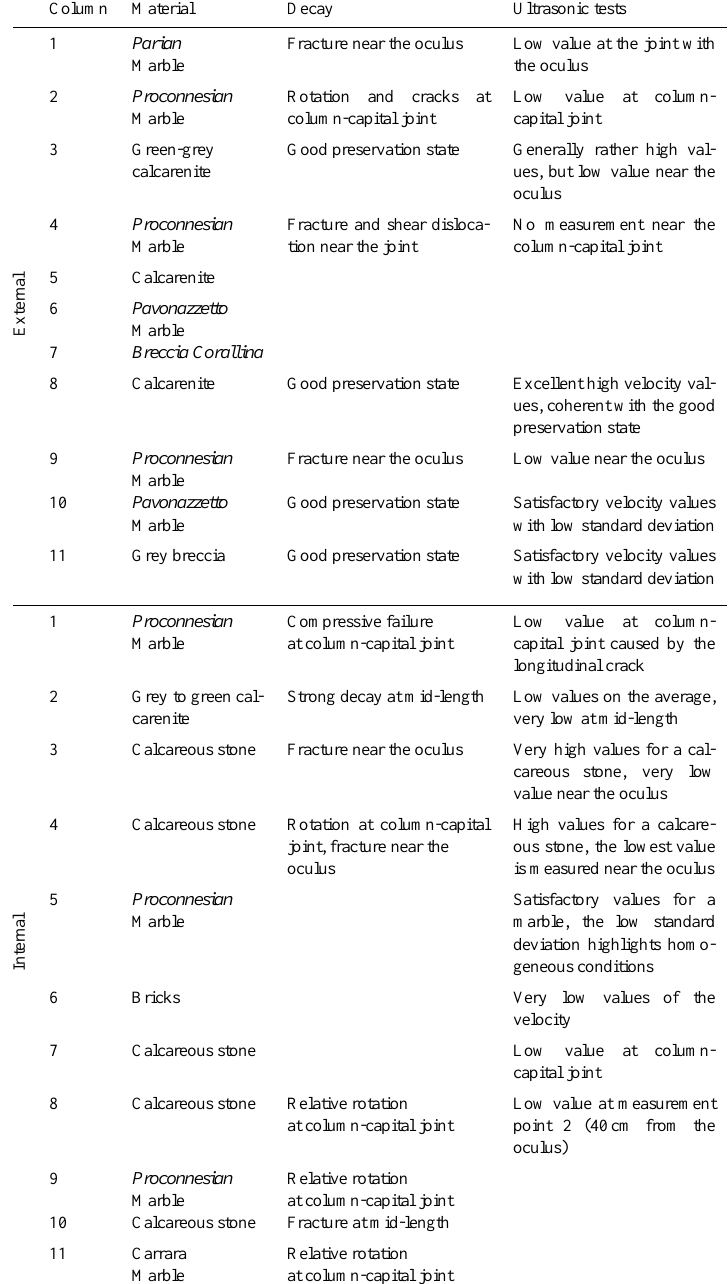
Table 3. Synthesis of materials, decay and ultrasonic tests on the columns. Column